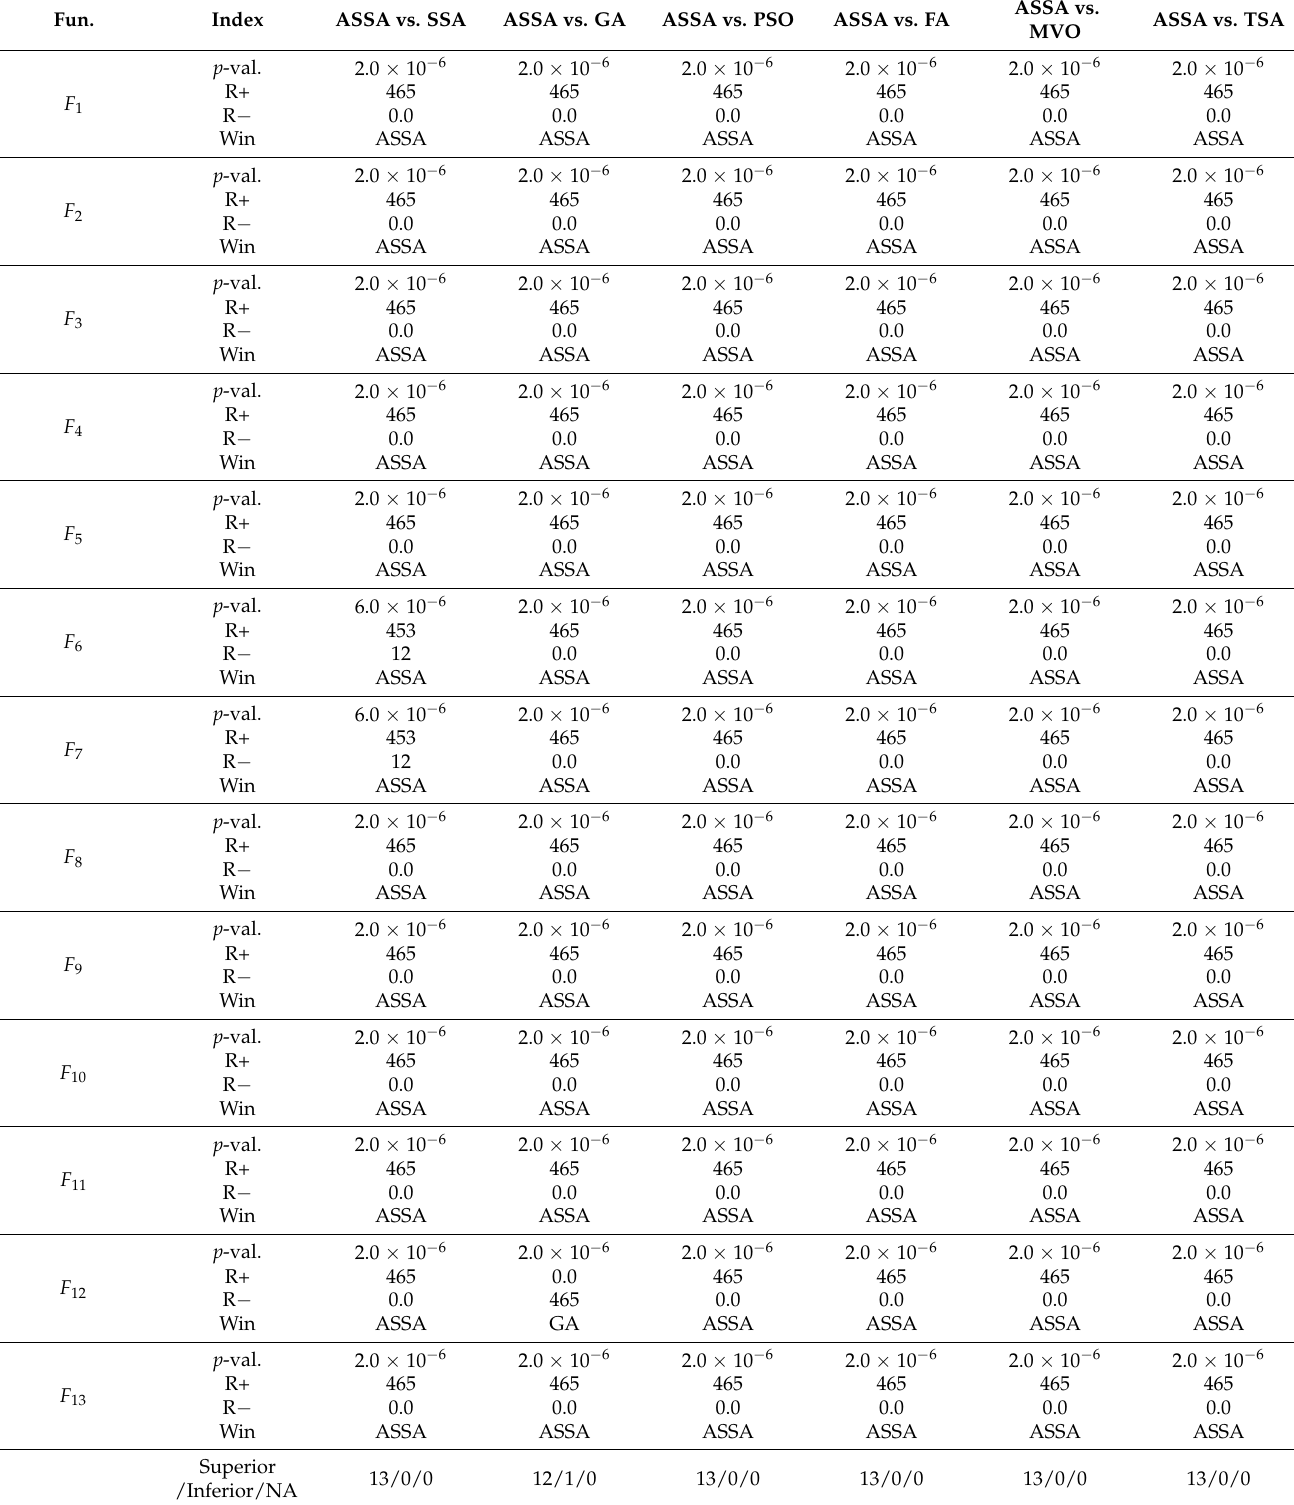
Table 6. Results of Wilcoxon’s rank sum test for benchmark